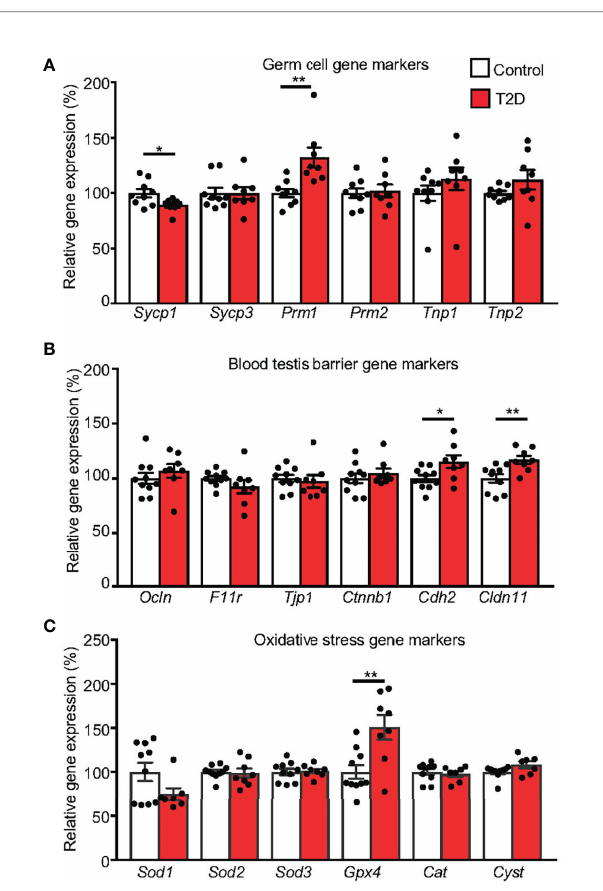
FIGURE 6 | Expression changes in the testes of the parental generation. (A) qPCR analysis of markers for spermatogenesis and spermiogenesis: Sycp1 , synaptonemal complex protein 1; Sycp3 , synaptonemal complex protein 3; Prm1 , protamine 1; Prm1 , protamine 2; Tnp1 , transition protein 1 and Tnp2 , transition protein 2; (B) Blood testis barrier markers: Ocln , occludin; F11r , F11 receptor; Tjp1 , tight junction protein 1; Ctnnb1 , catenin beta 1; Cdh2 , cadherin 2; Cldn11 , claudin 11 and (C) oxidative stress markers: Sod1, Sod2, and Sod3 , superoxide dismutase 1, 2, and 3; Gpx4 , glutathione peroxidase 4; Cat , catalase; and Cyct , cytochrome c. The control group represents 100% of relative gene expression. The values are means ± SEM, tested by t -test (GraphPad Prism 7.0). *P < 0.05, **P < 0.01.